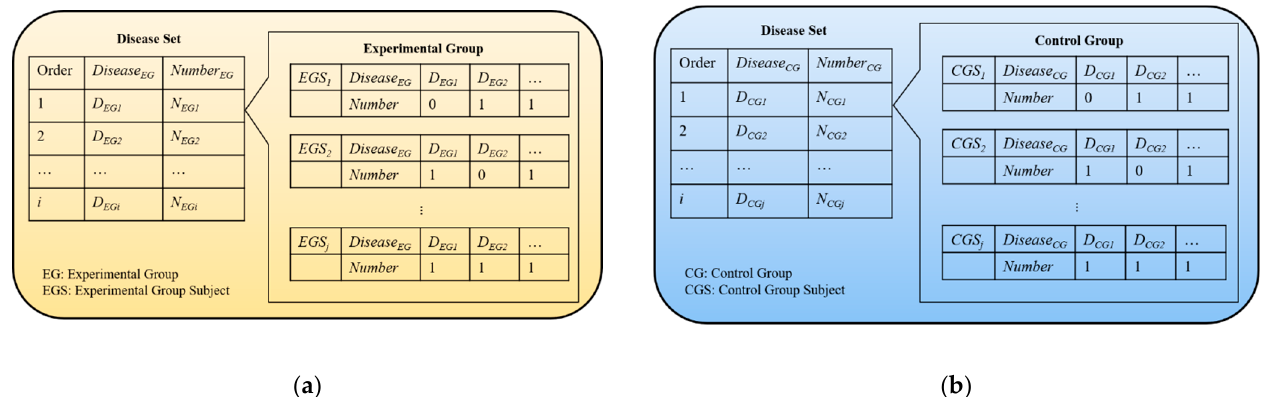
Figure 1. Illustration of the disease set from ( a ) the experimental group and ( b ) the control group: on the right part of the two tables are disease records of each subject, and each disease is displayed within the defined interval binary representation of 0 and 1. The left side is the disease set of the experimental/control group and the total number of subjects suffering various diseases. Disease EG and Disease CG refer to disease classification codes in the experimental and control groups, respectively. Number EG and Number CG refer to the total number of subjects in the experimental and control groups suffering from a certain disease. D EGi and D CGi refer to the i th disease classification code in the experimental and control groups, respectively. N EGi and N CGi refer to the total number of subjects in the experimental/control group suffering from the i th disease under a classification code. EGS j and CGS j refer to the j th subject in the experimental and control groups, respectively.